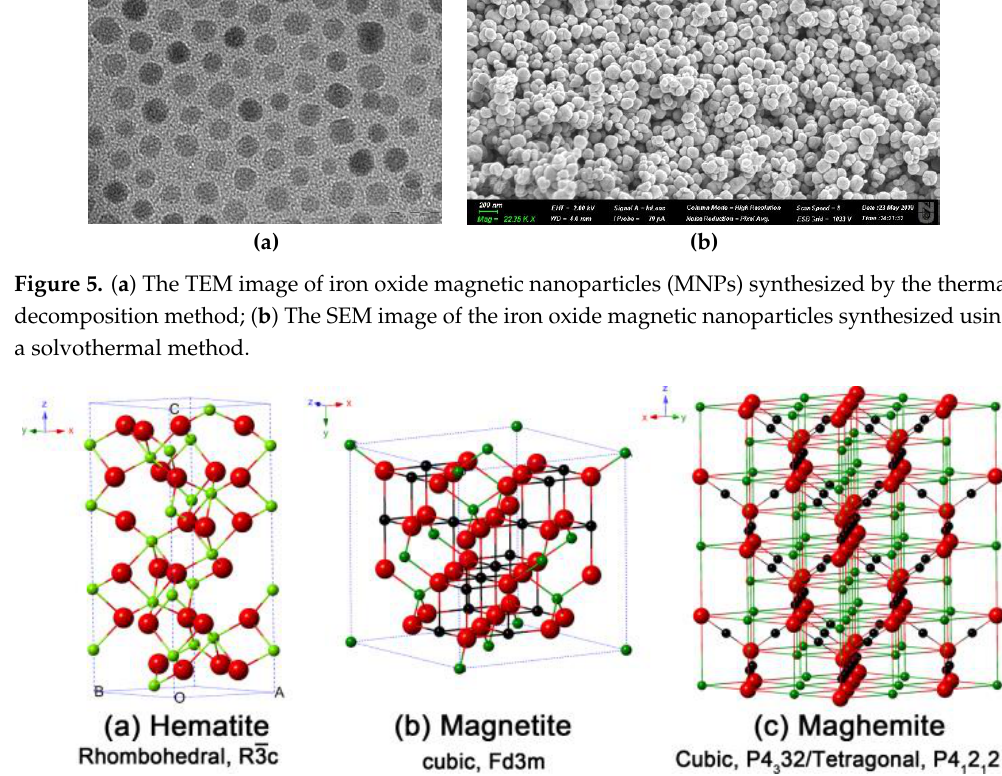
Figure 5. ( a ) The TEM image of iron oxide magnetic nanoparticles (MNPs) synthesized by the thermal decomposition method; ( b ) The SEM image of the iron oxide magnetic nanoparticles synthesized using a solvothermal method.